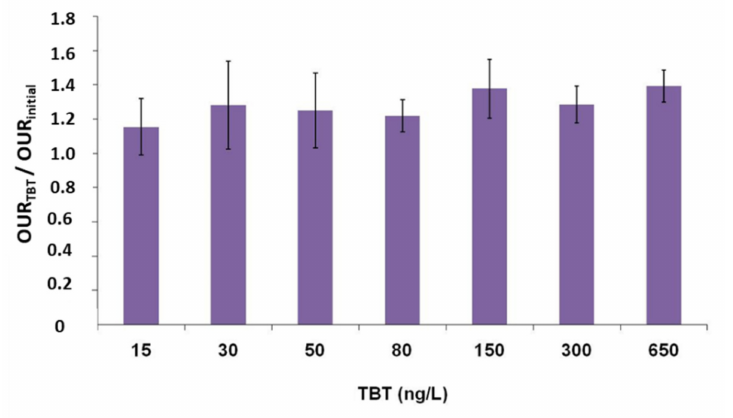
Figure 1. OUR TBT /OUR initial in endogenous conditions for different TBT concentration in the test reactor.